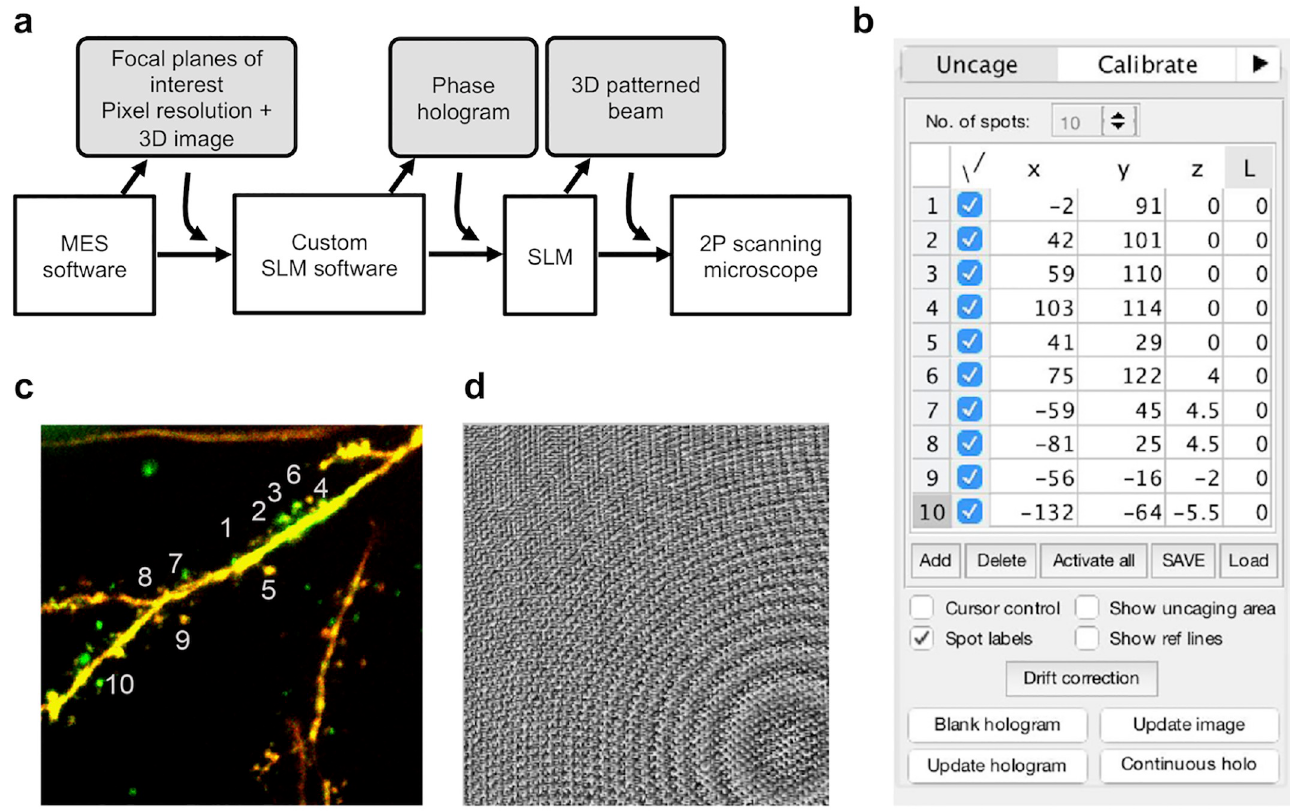
Fig 2. Software control of holographic projector. a : Interfacing between our custom SLM software and the rest of the system including the microscope’s control software (MES), which gathers the pixel resolution. b : Custom software graphical user interface showing xyz -coordinates of uncaging spots. We use the last column to encode a Laguerre-Gaussian beam of charge “L” to align the center of the SLM with respect to the optical axis. c : Two-photon 3D image of a basal dendrite with multiple spines. Positions of uncaging sites in b are indicated. d : The corresponding 8-bit phase-only hologram for projecting the multiple uncaging spots in b .